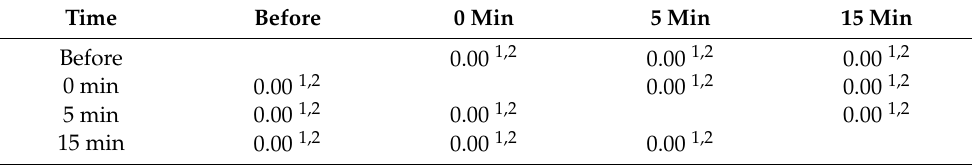
Table 3. Results of the post hoc Friedman ANOVA test for Groups A and B ( p < 0.05). Time Before 0 Min